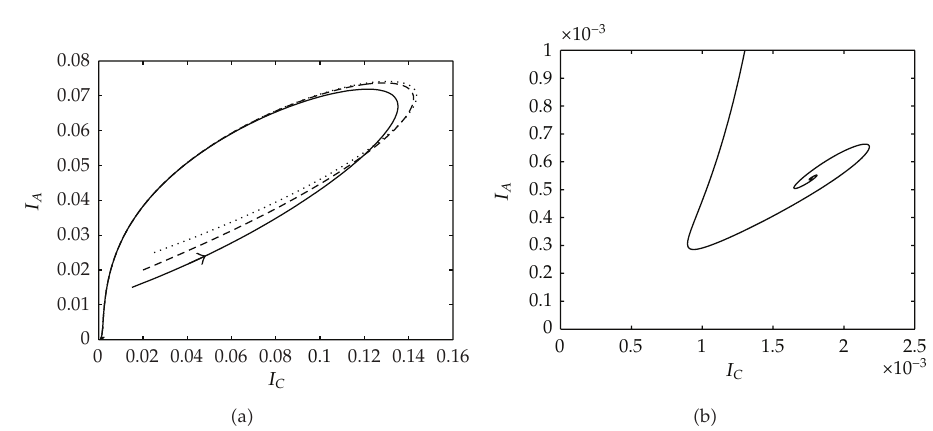
Figure 3: Projection of three orbits of model (cid:5) 2.13 (cid:6) – (cid:5) 2.18 (cid:6) on I C − I A plane (cid:5) a (cid:6) and the projection near the equilibrium state (cid:5) b (cid:6) . This projection indicates the local stability of the endemic equilibrium E e when R 0 >